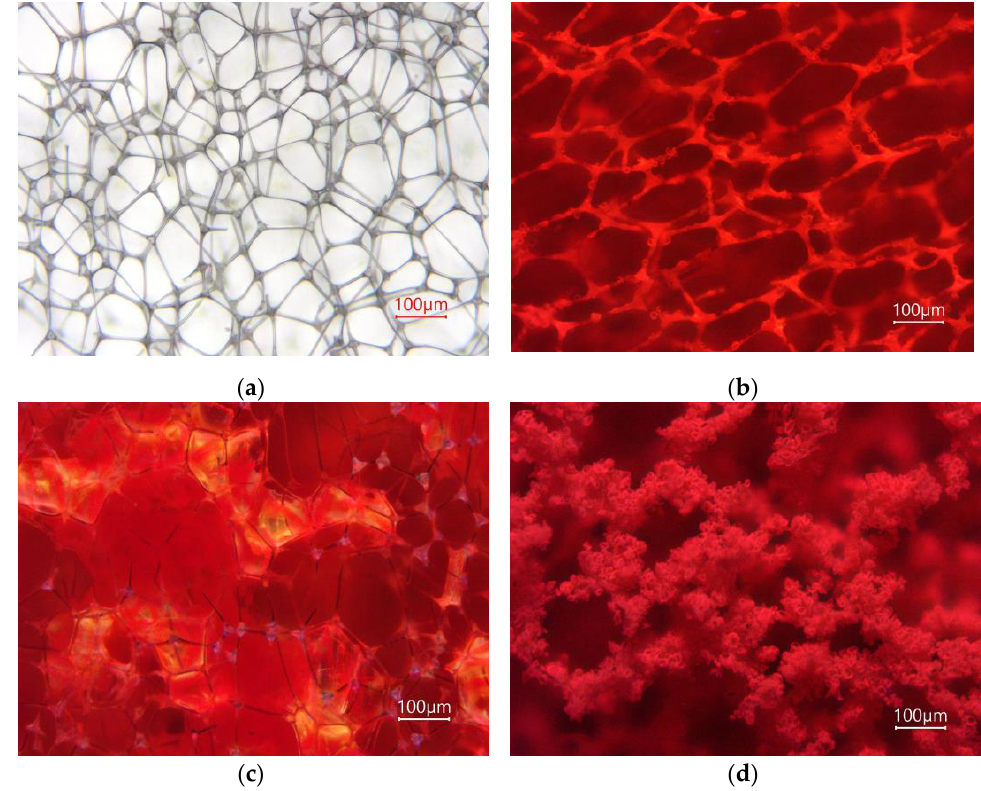
Figure 4. Microphotos of clean melamine formaldehyde foam substrate under white light illumination ( a ) and of obtained fluorescent sensor materials mF/Elsp ( b ), mF+PS ( c ), mF+PS/Elsp ( d ) under UV illumination.